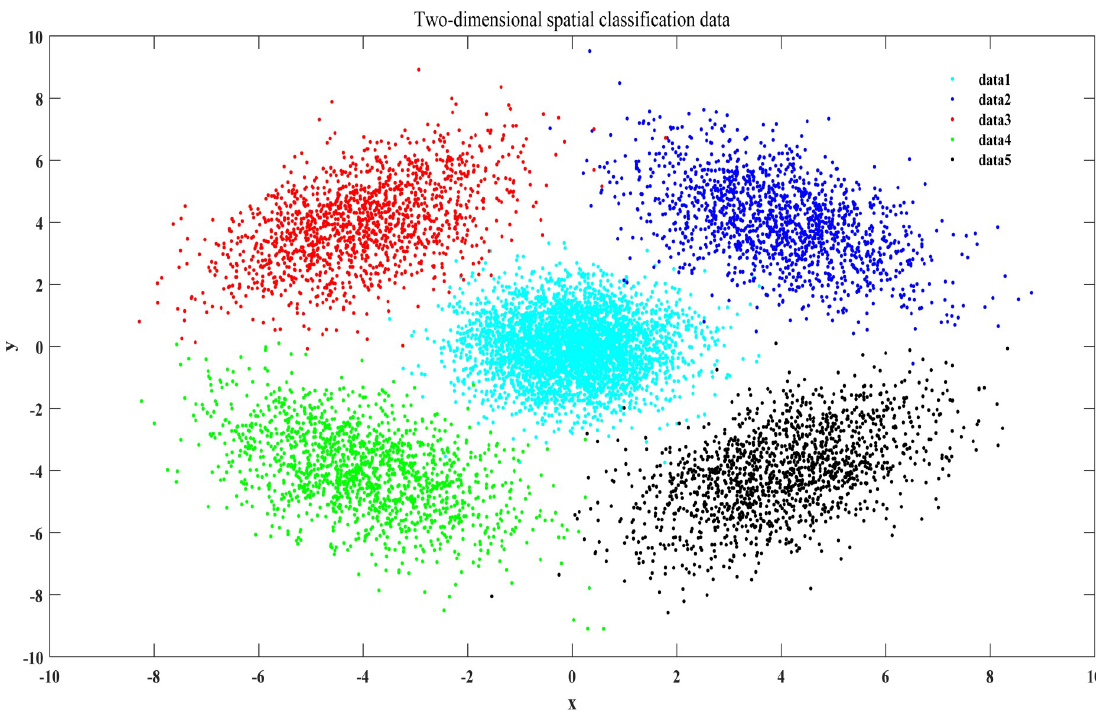
Fig 2. Two-dimensional spatial classification